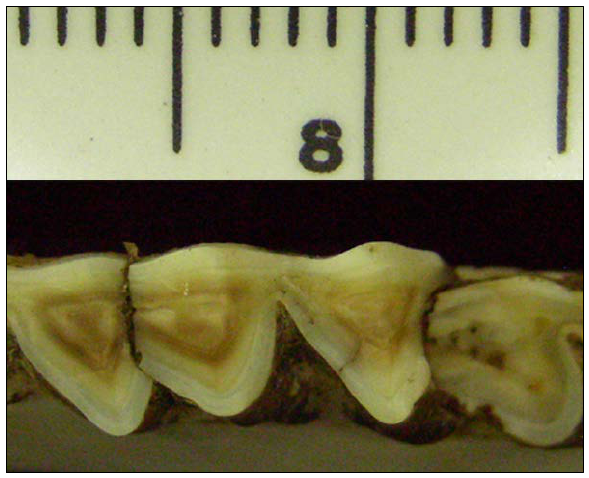
AZ 1491, a mandibular second molar that was classified correctly as a Neotragini, Raphicerus campestris (steenbok).